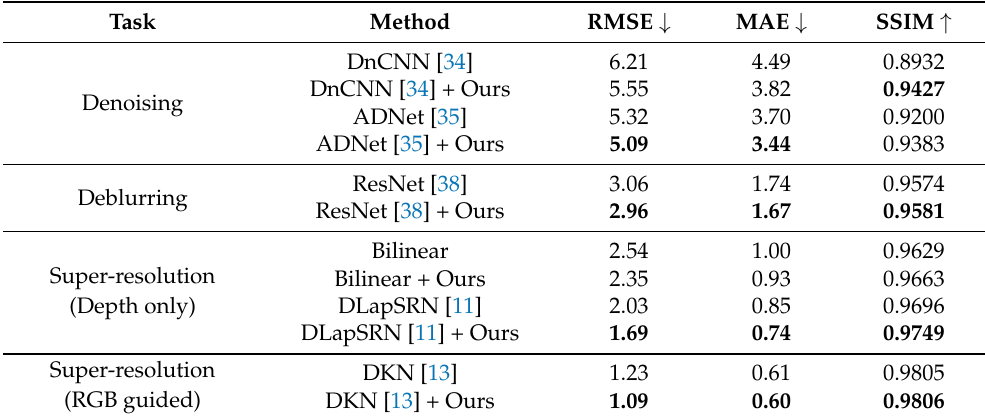
Table 3. Quantitative comparison of depth-map reconstruction for different tasks on the Middlebury dataset [37]. Values are given in pixel disparity as provided by the